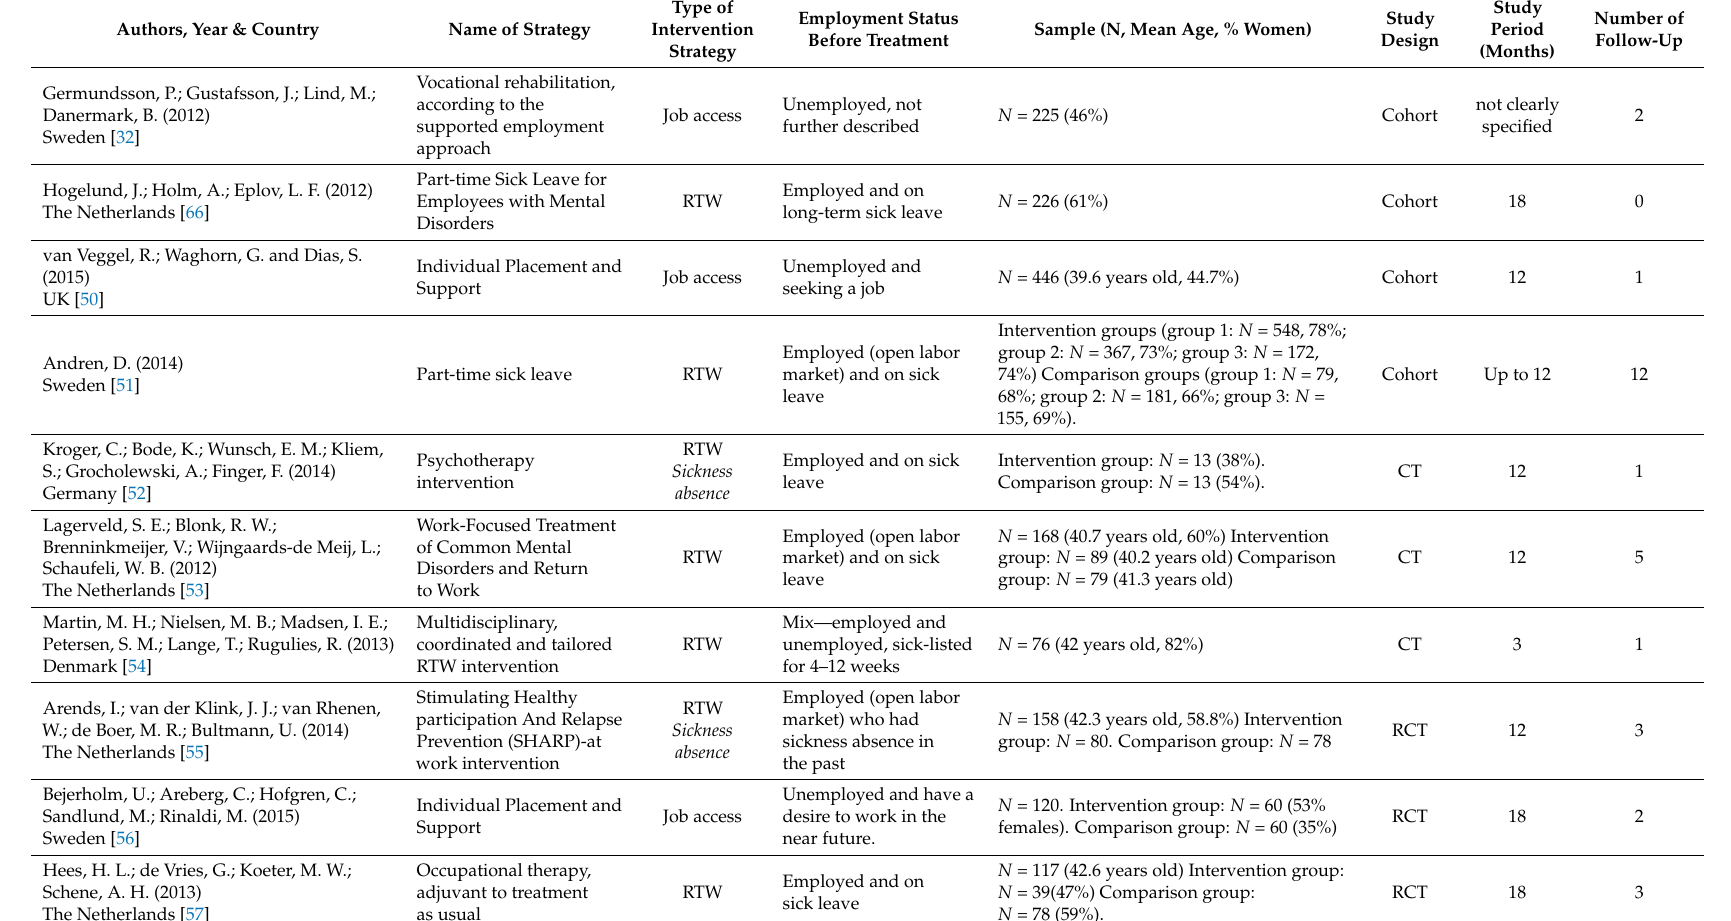
Table 1. Summary of the included European studies in